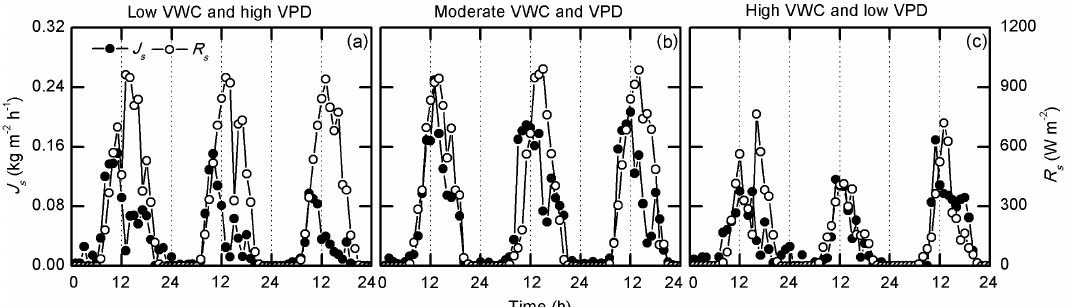
Figure 8. Sap flow per leaf area ( J s ) and shortwave radiation ( R s ) over three consecutive days in 2013, i.e., (a) under low volumetric soil water content (VWC) and high vapor pressure deficit (VPD; DOY 153–155, VWC = 0.064m 3 m − 3 , REW = 0.025, VPD = 2.11kPa), (b) moderate VWC and VPD (DOY 212–214, VWC = 0.092m 3 m − 3 , REW = 0.292, VPD = 1.72kPa), and (c) high VWC and low VPD (DOY 192–194, VWC = 0.152m 3 m − 3 , REW = 0.865, VPD = 0.46kPa); REW is the relative extractable soil water and DOY is the ordinal day of the year. VWC, REW, and VPD give the 3-day mean value.